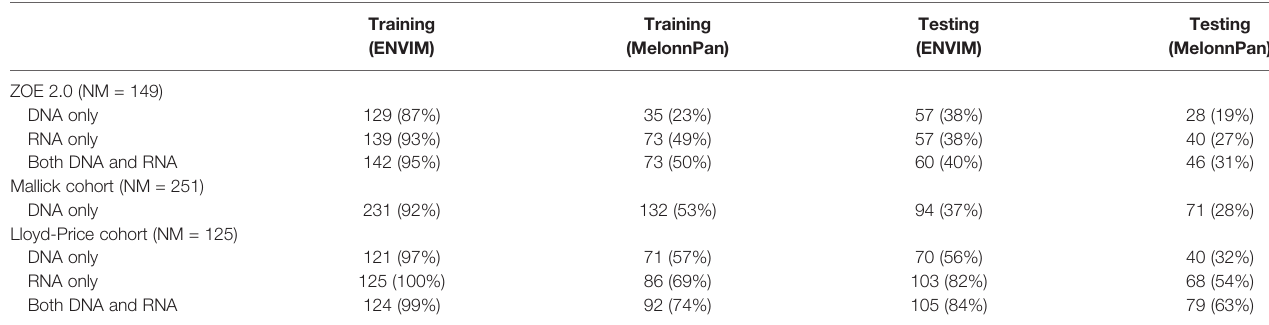
TABLE 5 | Prediction results via Spearman correlation for metabolites that are found in metabolic